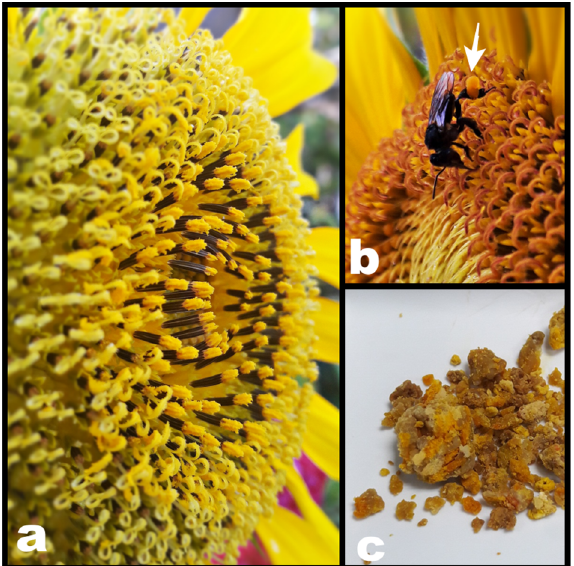
Figure 3. ( a ) Flower pollen, ( b ) bee pollen on the stingless bee ( Heterotrigona itama ) hind leg, and ( c ) fermented bee pollen (bee bread) collected from the stingless bee cerumen